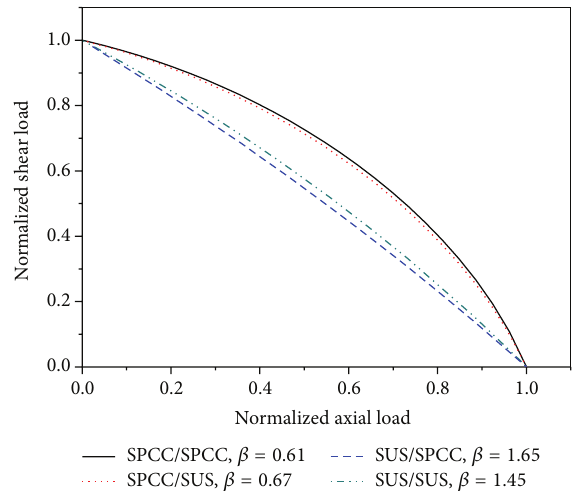
Figure 12: Normalized failure contours for the FSSW joints with four different material combinations based on the failure criterion of Song and Huh